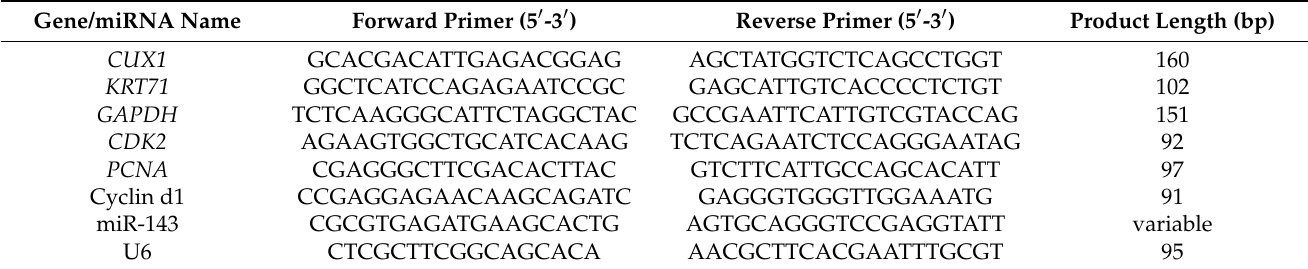
Table 1. The primer information of qRT-PCR.